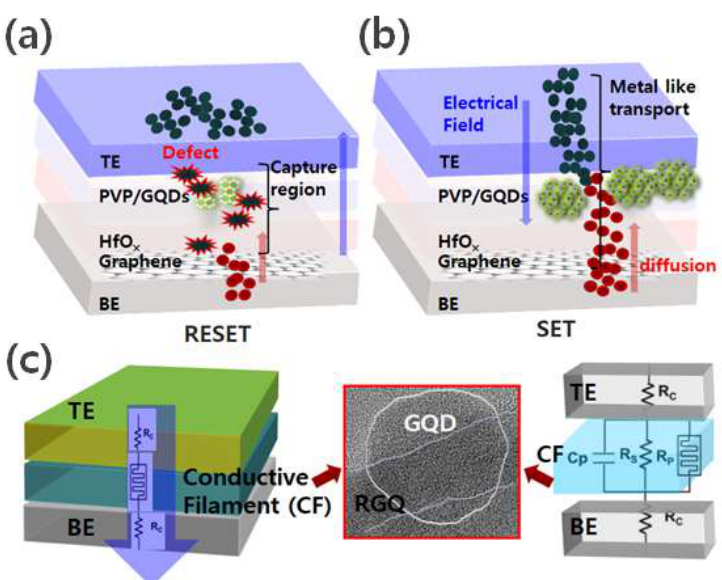
Figure 4. ( a ) Schematic illustrating the device structure with an atomic defect in PVP GQD layer; ( b ) oxidation of Al to Al + ions and diffusion of Al + ions into PVP GQD layer, reduction of Al + ions. ( c ) Schematic of the conductive filament (CF) evolution model in the SET process and equivalent circuit with parasitic effects.